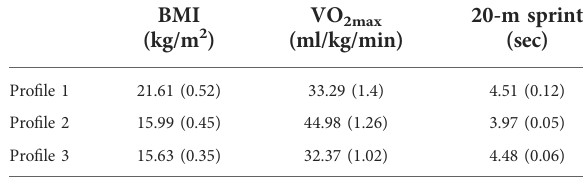
TABLE 2 Fit statistics of the latent pro fi le analysis models. TABLE 3 Characteristic of classi fi ed three pro fi les.